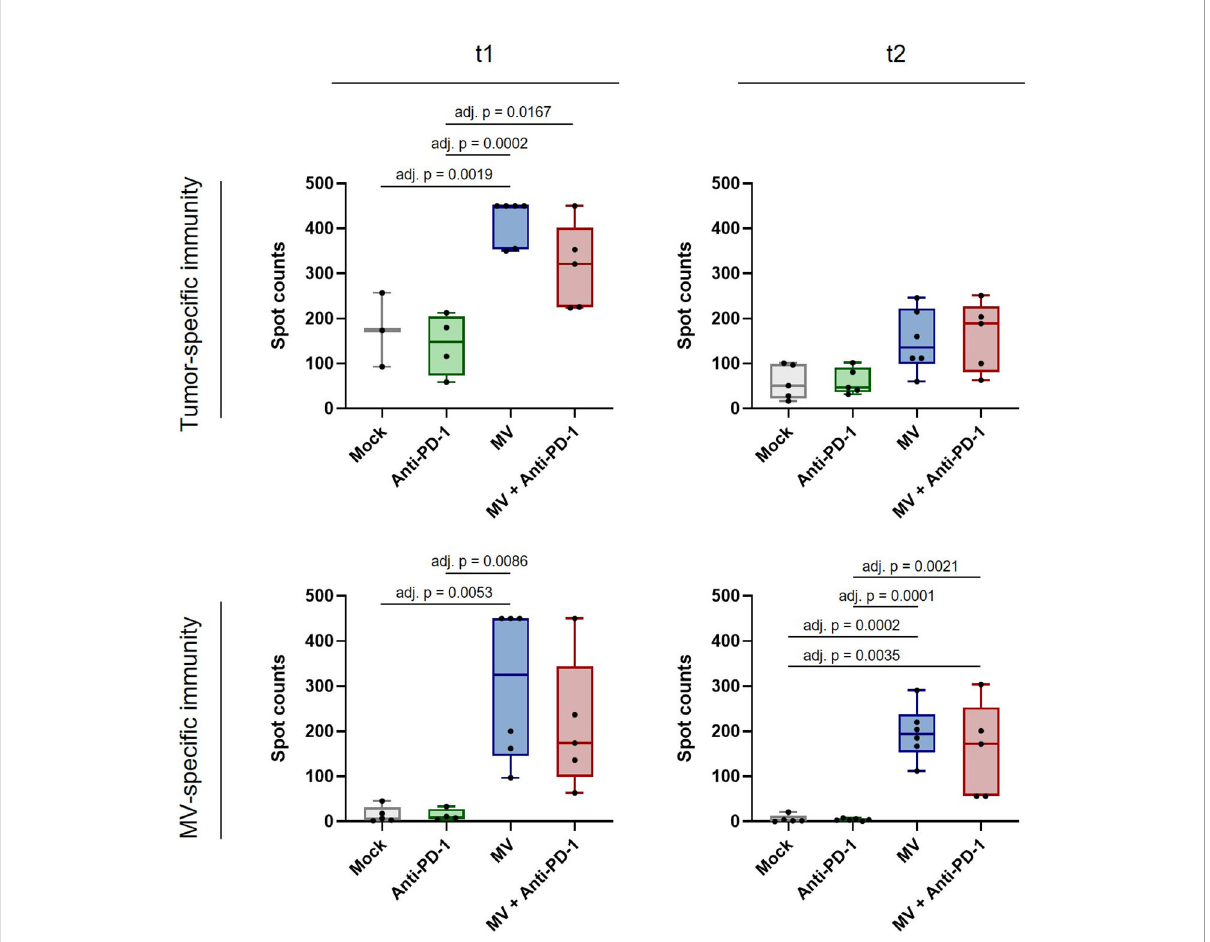
FIGURE 7 Anti-tumor and anti-measles immunity after MV and anti-PD-1 treatment. C57BL/6J mice bearing subcutaneous FC1245-CD46 tumors were treated as described in methods, with treatment starting on day 4 after tumor implantation. Spleens were collected at t1 and t2, co-cultured with indicated stimuli and IFN- g ELISpot was conducted. Box and whisker plots with whiskers depicting minimal and maximal values as well as median in each group are shown. Dots represent individual mice. Saturated wells were set to 450 spots. Data were analyzed using one-way ANOVA with Tukey ’ s correction for multiple comparisons. adj. p = adjusted p